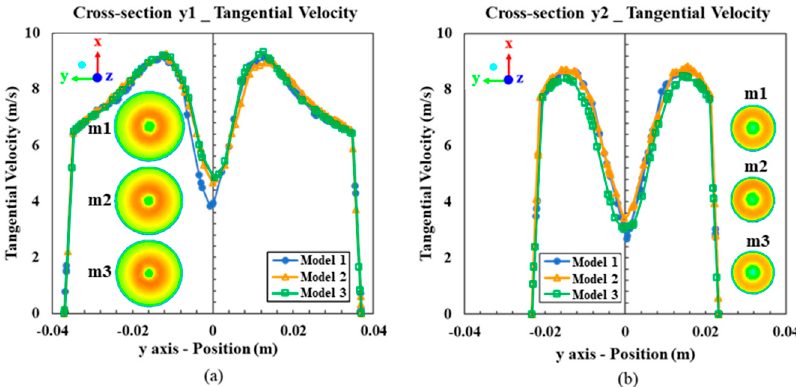
Figure 9. Tangential velocity profile y1 (cylindrical center) and y2 (conical center); ( a ) Tangential velocity at y1 and ( b ) Tangential velocity at y2.